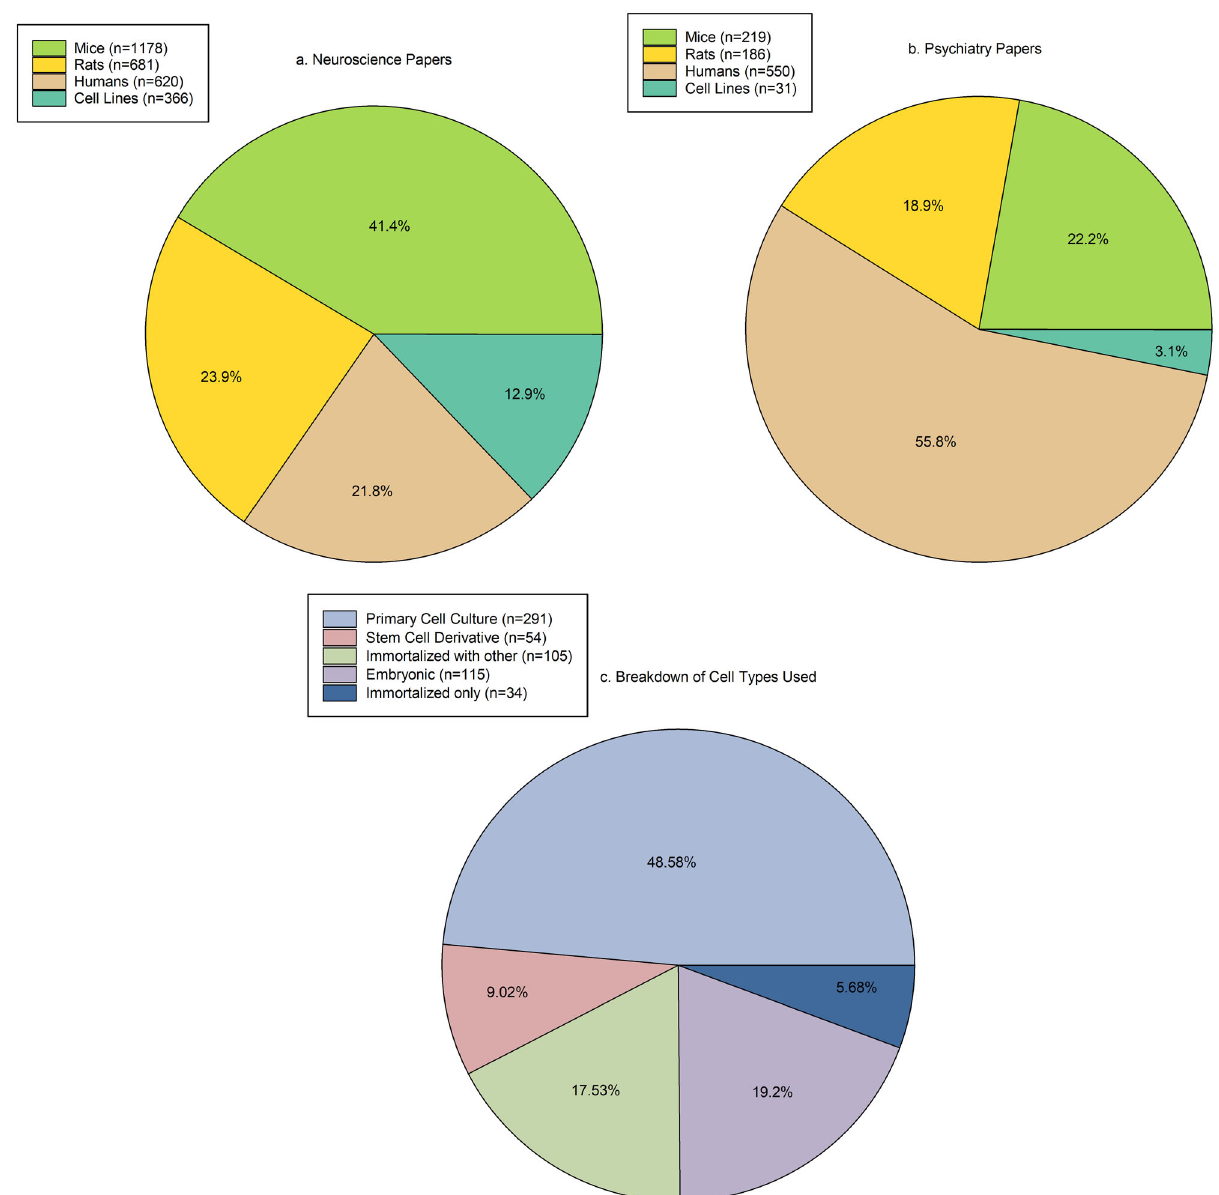
Fig. 2 Reported species model in each paper sampled across our survey. a Rodents (mice ( n = 1178) and rats ( n = 681)) were the most common species by studies in the papers from the neuroscience journals analysed. b Human subjects ( n = 550) were the most common species used by studies in the papers in the psychiatry journals analysed. Sample sizes ( n ) are the number of papers that reported studies that used the model systems and will total to greater than 3193 as some papers reported studies used two or more model systems. c Breakdown of type of cell line used in studies reported in the papers. The largest proportion of papers reported studies that used primary cell lines. Of the papers that reported studies that used cell lines, the majority reported use of primary cell culture ( n = 291). The other types of cell line reported in the papers were stem cell derivatives ( n = 54), immortalised with other cell types ( n = 105), embryonic ( n = 115), and immortalised only ( n = 34). Sample sizes are the number of papers and will total greater than 397 as some papers reported studies used two or more cell lines. We relied on the paper to distinguish whether cell lines were conducted in males or females, regardless of the cell line used, and if information was not available on the sex of the cells, they were categorised as sex not reported. Source data are provided as a Source Data fi